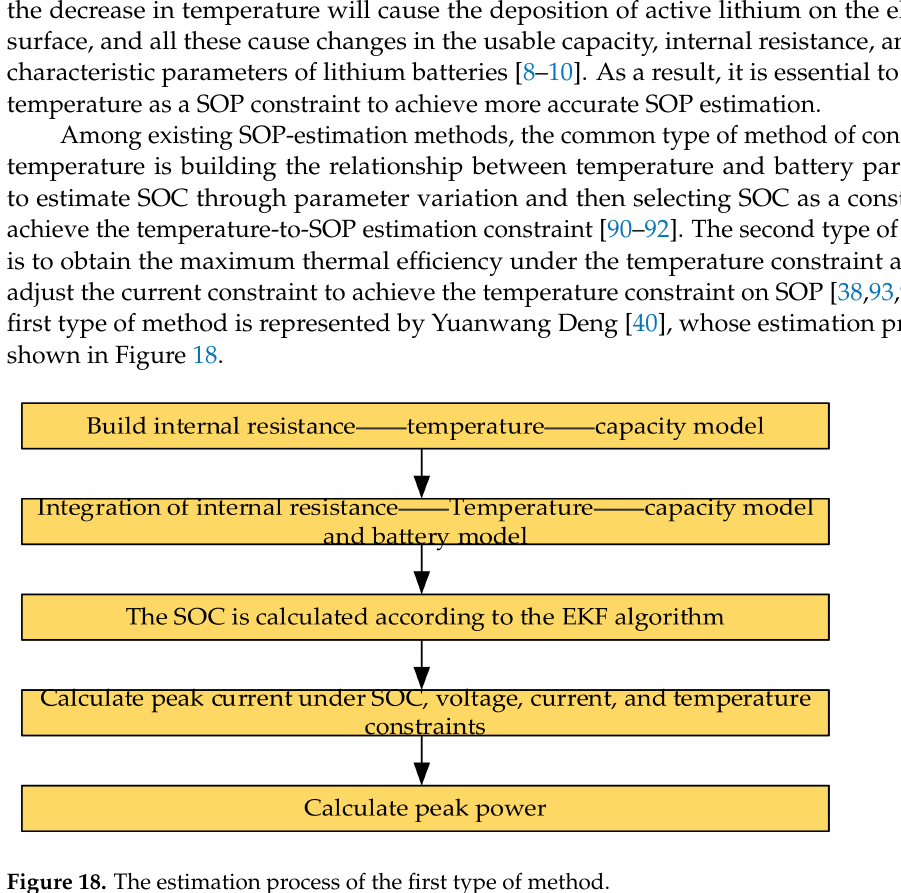
Figure 18. The estimation process of the first type of